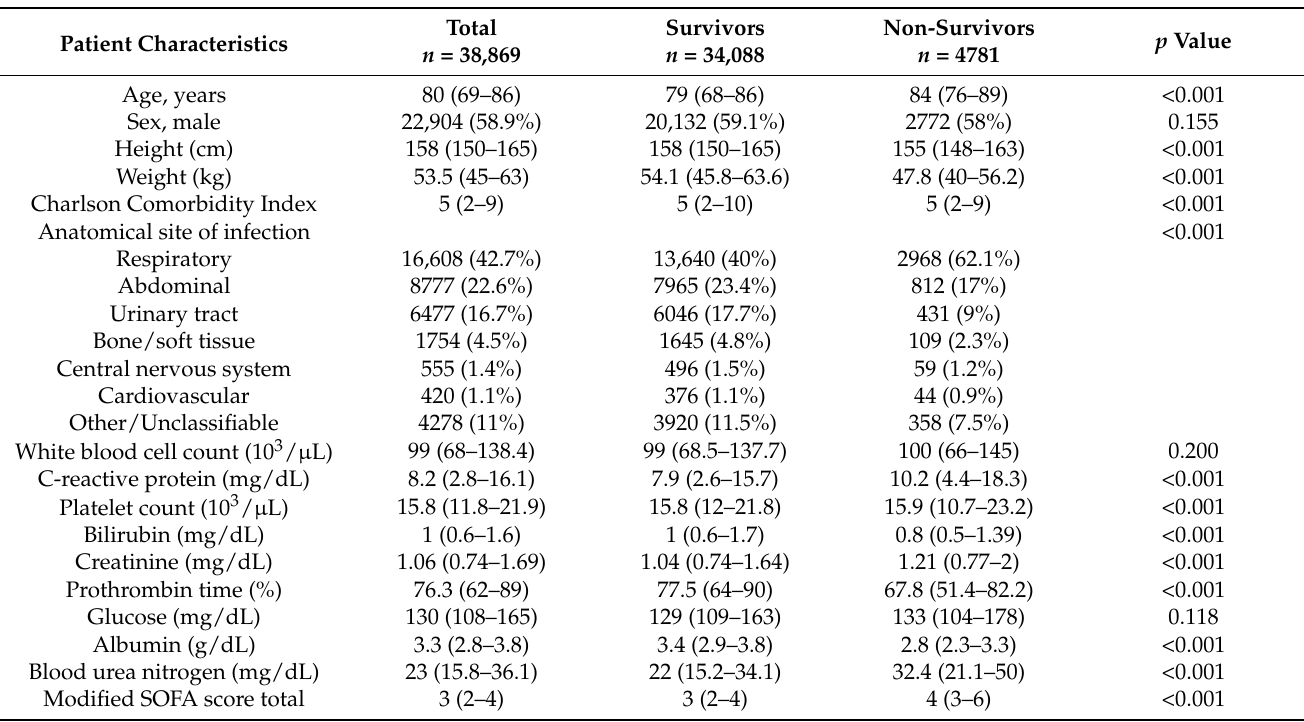
Table 1. Patient